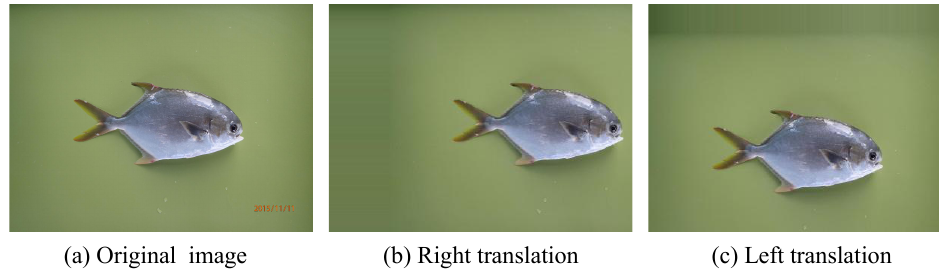
Fig. 5. Effect of the translation transformation. Figure 6. Data augmentation by translation transformation.